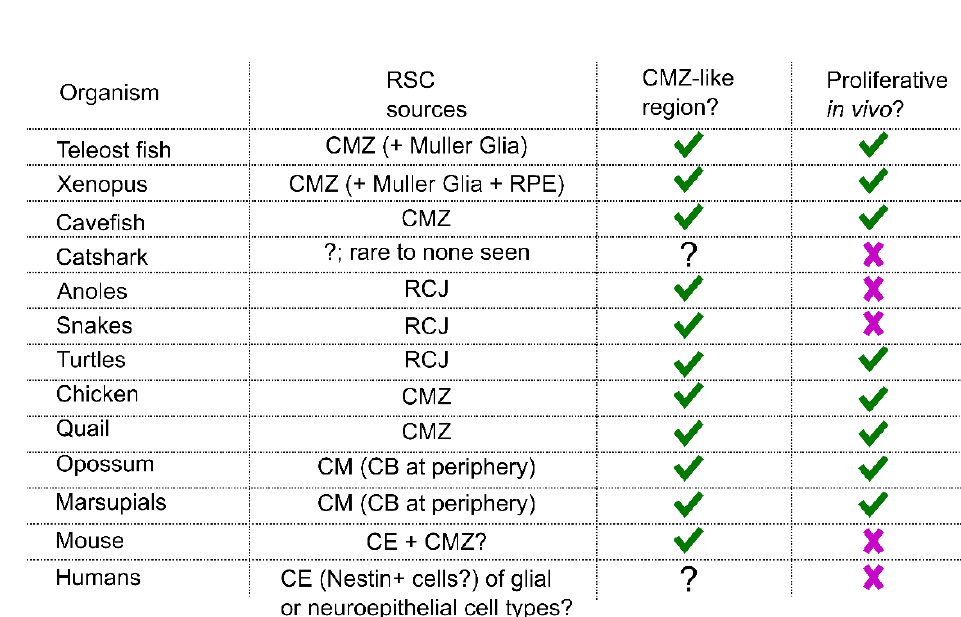
Figure 1. Conservation of a CMZ-like region across different species. ( A ) Schematic of the development and specification of cells in the eye into the retinal pigmented epithelium (RPE, grey ), neural retina (NR, pink ) and ciliary epithelium (CE, pigmented— grey , non-pigmented— green ). The inner layer of cells gives rise to the NR, while the outer layer gives rise to the RPE. The region in the middle, between the NR and RPE, gives rise to the CE, as seen in the right image. The highlighted square in the top right image shows what regions are found in the ‘ciliary margin,’ which includes both CE and the CMZ (CE = ciliary epithelial cells, CMZ = ciliary/circumferential marginal zone). This eye representation is typical of what a teleost fish/ Xenopus eye looks like. The bottom right image shows the ciliary margin of species, such as mammals (e.g., mice), with more extensive CE development. Morphology and development can vary between species, but this is meant to highlight the variability that exists. ( B ) Summary of the characterization of CMZ cells across different organisms. Green checkmarks indicate that data supports the presence of these features, magenta ‘X’ indicates that data suggests these features are not present, and ‘?’ indicates that the data is insufficient to make a conclusion. Abbreviations: CMZ = ciliary marginal zone, RCJ = retinociliary junction, CM = ciliary margin, CB = ciliary body and CE = ciliary epithelium. A question mark is used when not enough evidence to date has been found to conclude the presence of a CMZ-like region.